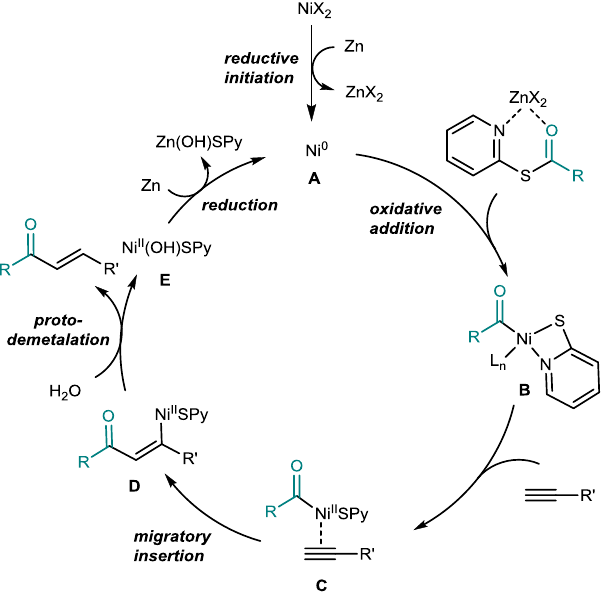
Fig. 4 Proposed catalytic cycle. Synthesis of non-tethered E -enones via the Ni-catalyzed aldehyde-free alkyne